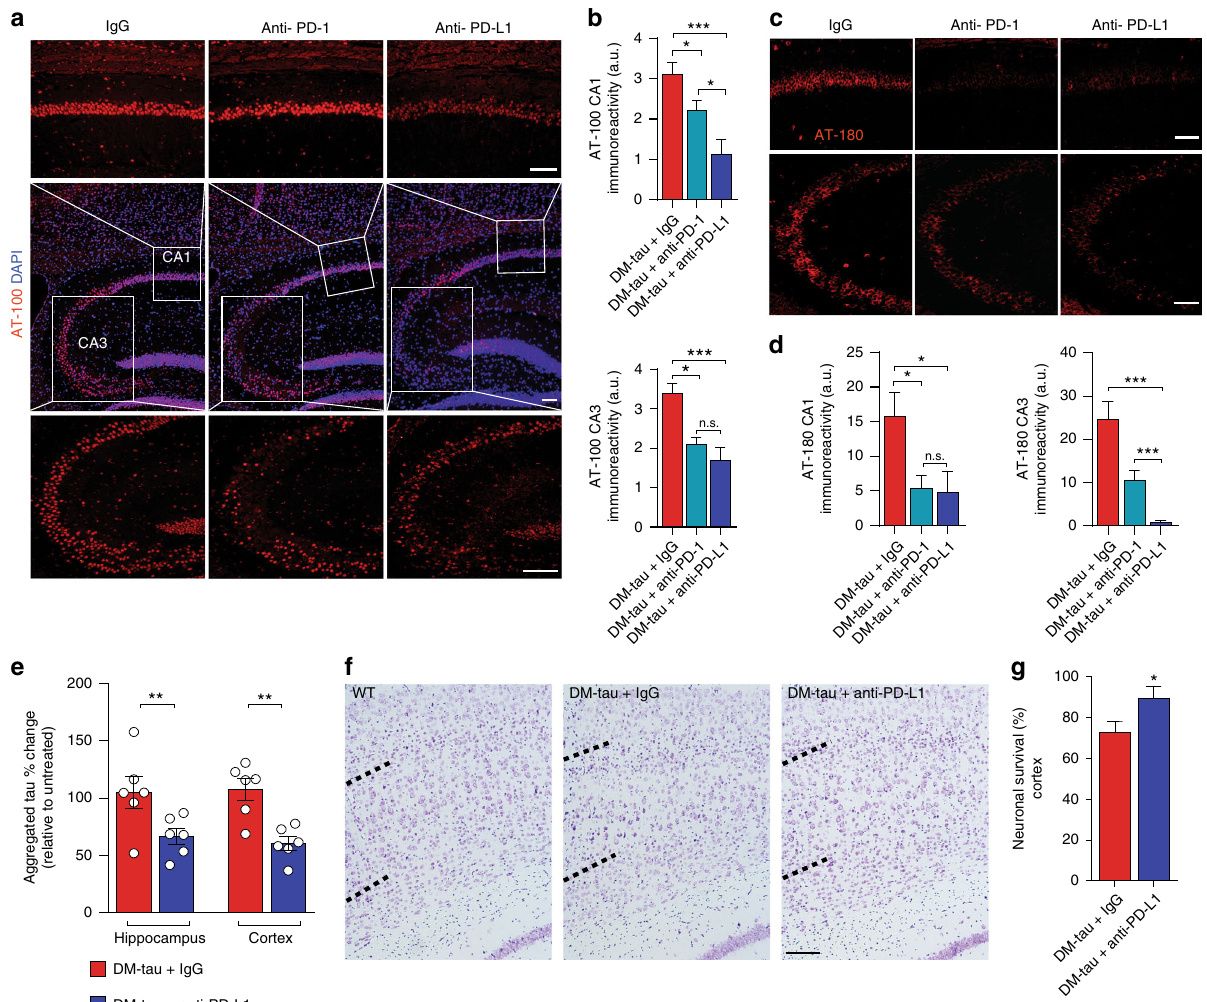
Fig. 4 Blocking PD-1/PD-L1 pathway reduces tau hyperphosphorylation in DM-tau mice. Immunostaining of tau-phosphorylation in brains of 8-month-old male DM-hTAU mice excised 1 month after treatment with anti-PD-1, anti-PD-L1, or isotype-matched control antibody (IgG). The analyzed mice were taken from the experiment in Fig. 3d ( a – d ). a Representative immuno fl uorescence images, and b quantitative analysis of AT-100. Immunoreactivity of AT- 100 was measured in the hippocampal CA1 and CA3 regions of DM-hTAU + IgG ( n = 11), DM- hTAU + anti-PD-1 ( n = 10), and DM-tau + anti-PD-L1 ( n = 4). c , d Representative immuno fl uorescence images, and quantitative analysis of AT-180 staining. Immunoreactivity of AT-180 was measured in the hippocampal CA1 and CA3 regions of the following treatment groups DM-hTAU + IgG ( n = 11), DM-hTAU + anti-PD-1 ( n = 10), DM-hTAU + anti-PD-L1 ( n = 4) (one-way ANOVA and Fisher ’ s exact test). Scale bars, 100 μ m ( a , c ). e Hippocampal and cortical levels of aggregated tau, measured in the protein extracts of the mice shown in Supplementary Fig. 7. Results are normalized to mg protein, and are expressed relative to untreated DM-hTAU; n = 6 per group (Student ’ s t test). f , g Representative Cresyl violet-stained images of the cortex and quanti fi cation of cortical layer fi ve neurons, of male and female DM-hTAU mice (average cohorts aged 9 months) treated with anti-PD-L1 ( n = 6) compared to IgG control group ( n = 7); the wild-type ( n = 6) controls that were analyzed were used to determine the percentage of surviving neurons. (Student ’ s t test). Scale bars, 100 μ m. In all panels, error bars represent mean ± s.e.m.; * P < 0.05, ** P < 0.01, *** P <